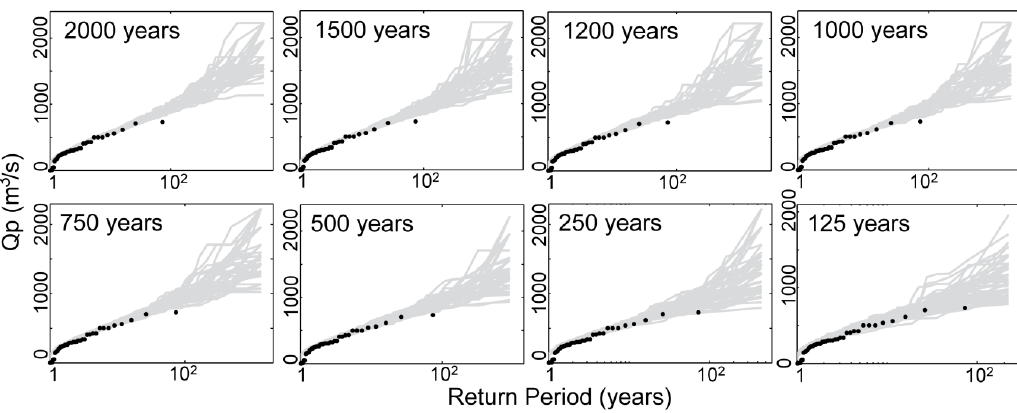
Figure 13. Peak flow frequency curves obtained from 2000, 1500, 1200, 1000, 750, 500, 250 and 125 years series for the Corbès basin.